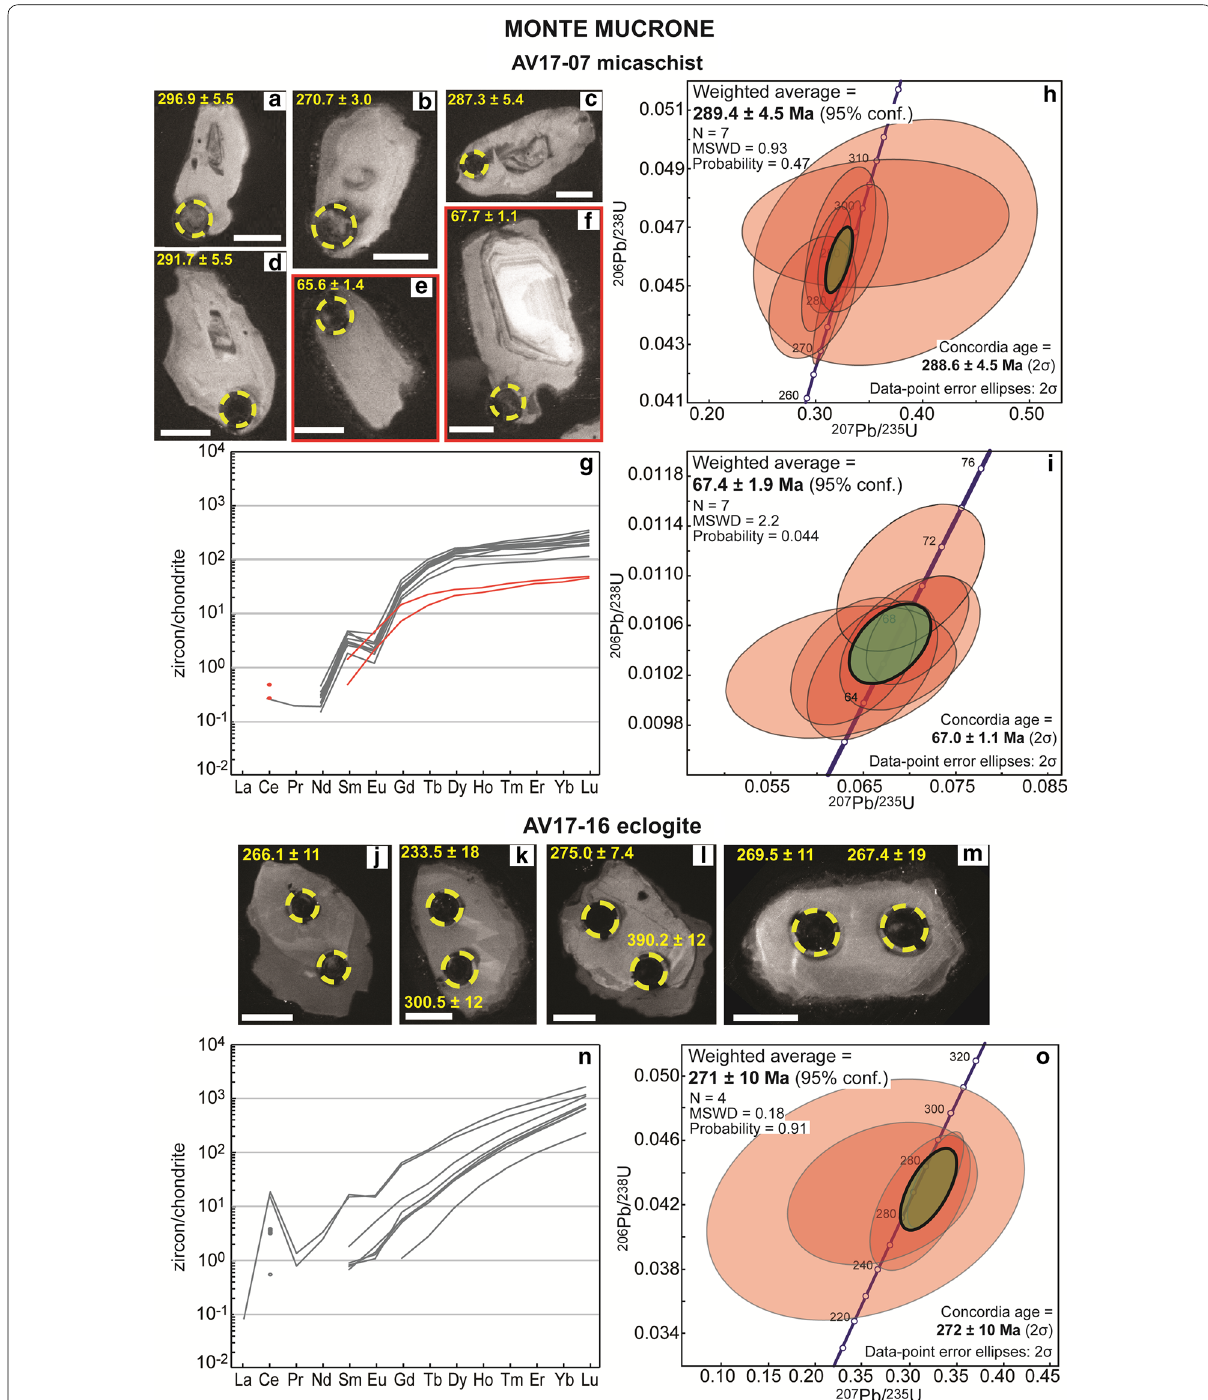
Fig. 10 Zircon in samples from Monte Mucrone. Micaschist AV17-07: a – f Selected CC images of analysed zircon grains. Scale bar in all images is 30 μm. Measured spots are shown (yellow circles) with the associated date ( 1σ Ma). The two grains yielding Alpine ages are marked by a red ± frame. g REE patterns of zircon domains of Permian age (rim1, grey lines) and of Alpine age (rim2, red lines). h Concordia plot for zircon rim1 and weighted average 206 Pb/ 238 U age. The green circle represents the calculated Concordia age. i Concordia plot for zircon rim2 and weighted average 206 Pb/ 238 U age. The green circle represents the calculated Concordia age. Eclogite AV17-16: j – m CC images of the recovered and analysed zircon grains. Scale bar in all images is 30 μm. Measured spots are shown (yellow circles) with the associated date ( 1σ Ma). n REE patterns of zircon ± cores. o Concordia plot for zircon core and weighted average 206 Pb/ 238 U age. The green circle represents the calculated Concordia